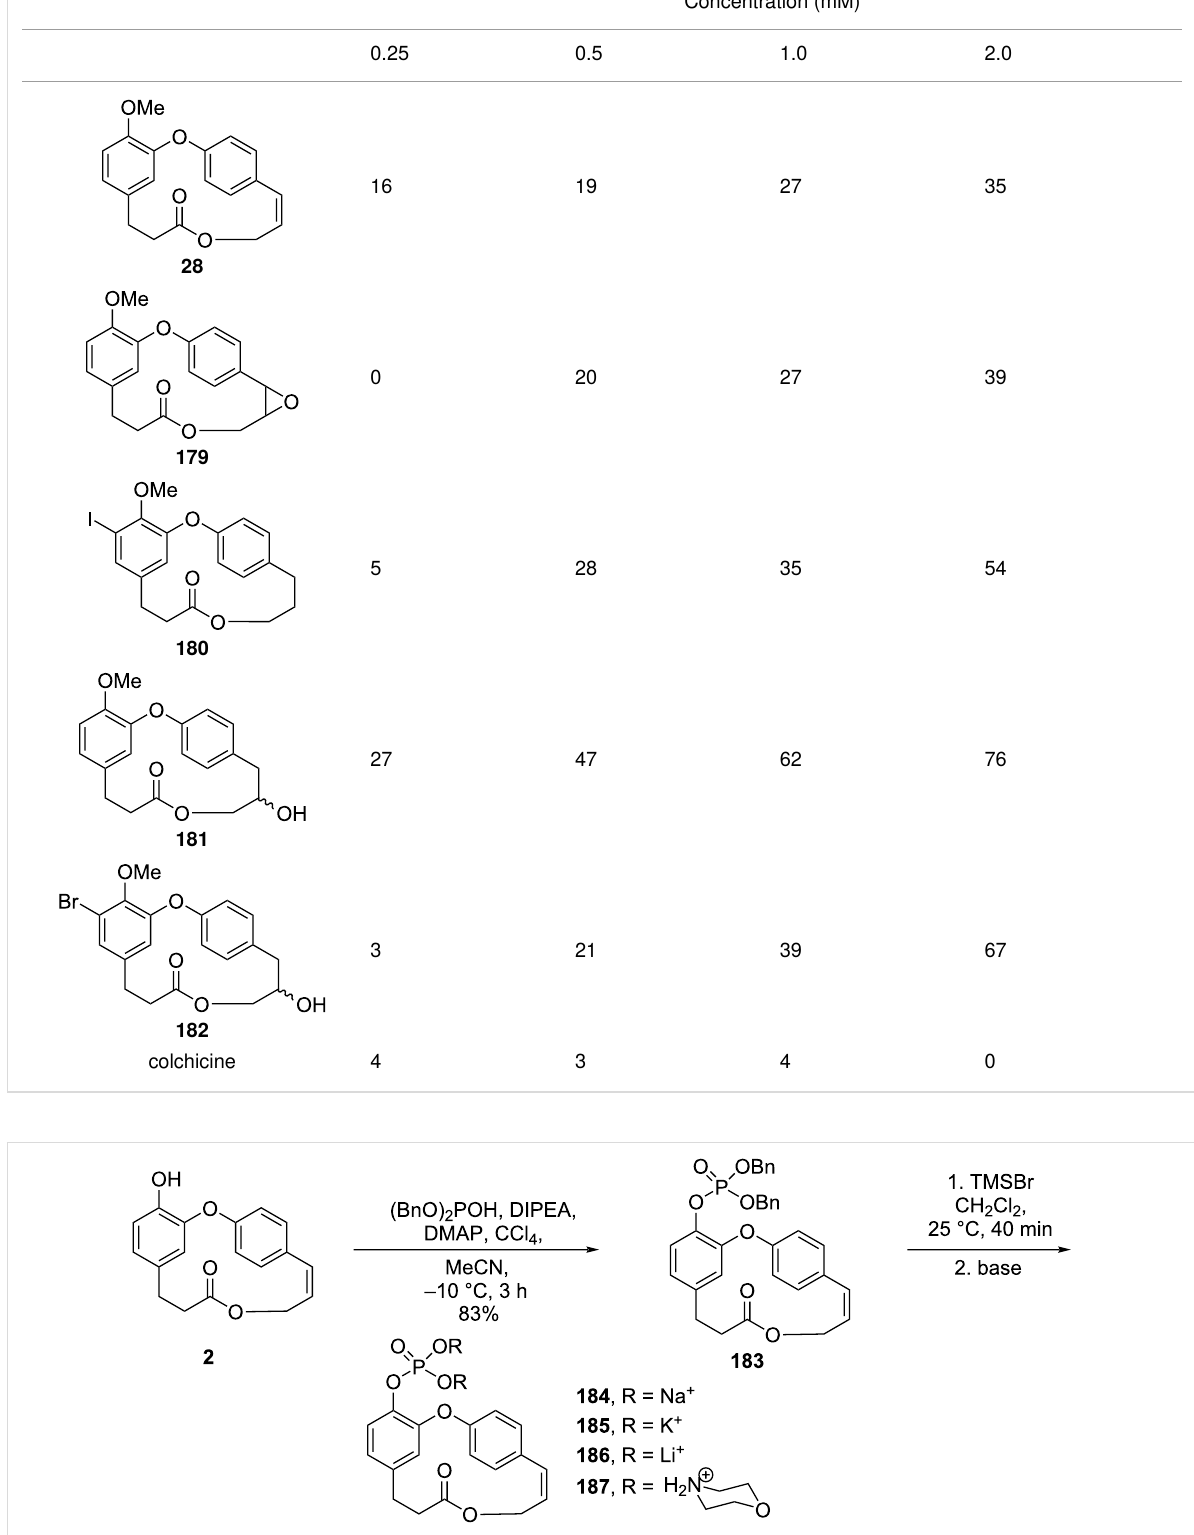
Scheme 35: Synthesis of combretastatin D-2 prodrug salts